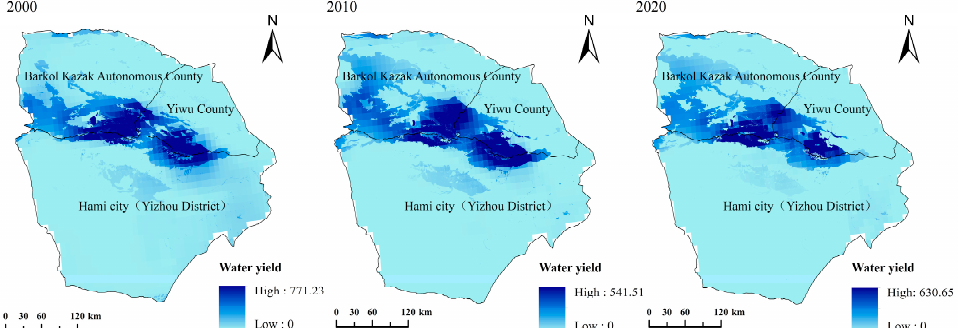
Figure 8. Spatial distribution of the water yield in Hami city.